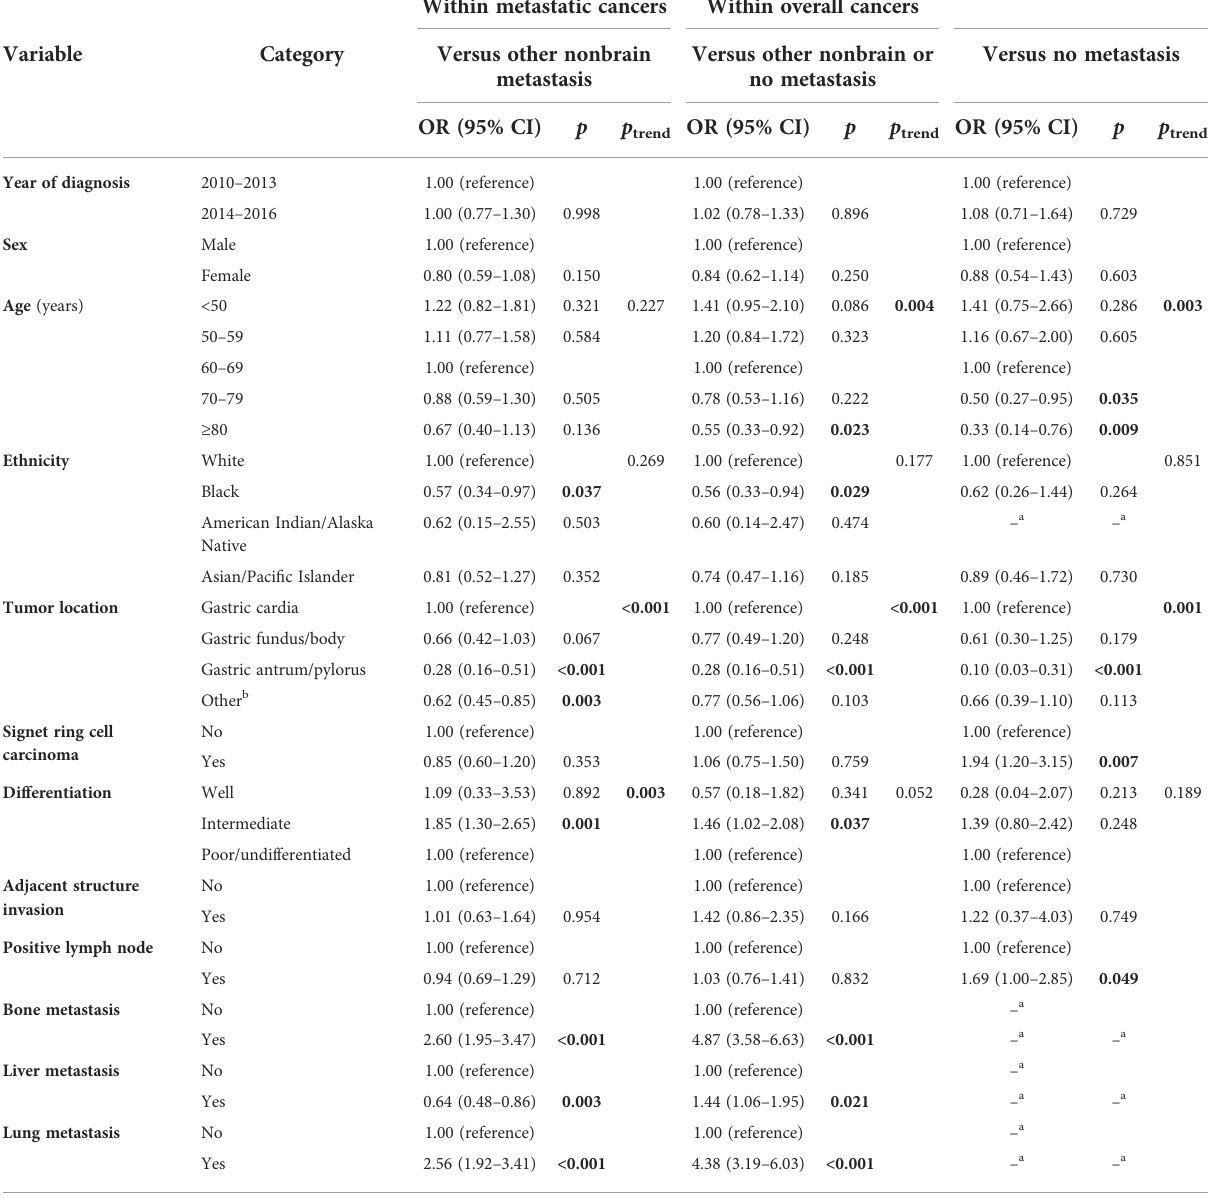
Oddsratiosand95%con fi denceintervalsforthevariableslistedinthe fi rstcolumnexcepttumordifferentiationwerecalculatedutilizingthelogisticregressionmodelmutuallyadjustedfor these variables. For tumor differentiation, adjacent structure invasion, and positive lymph nodes with missing values, the association was assessed by additionally including these